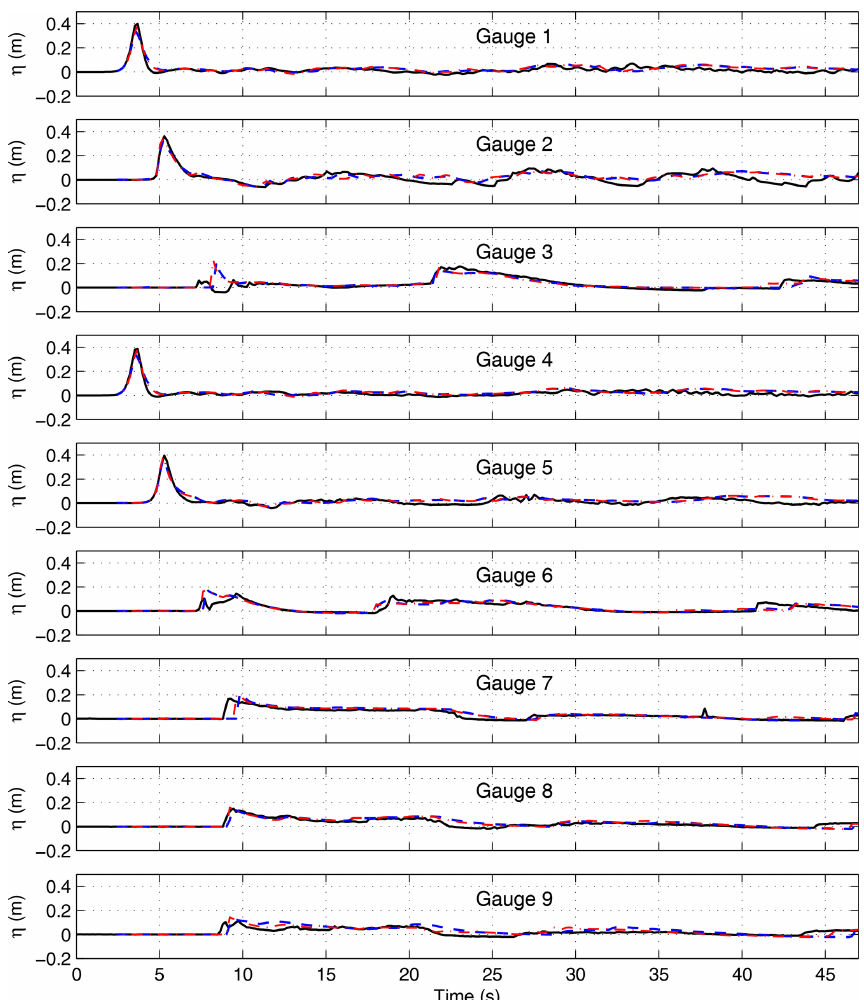
Figure 13. Case of Fig. 11. Comparison of surface elevations at wave gauges in (solid) experiments and (blue and red dashed, respectively) results of the present nested and original FUNWAVE-TVD models.